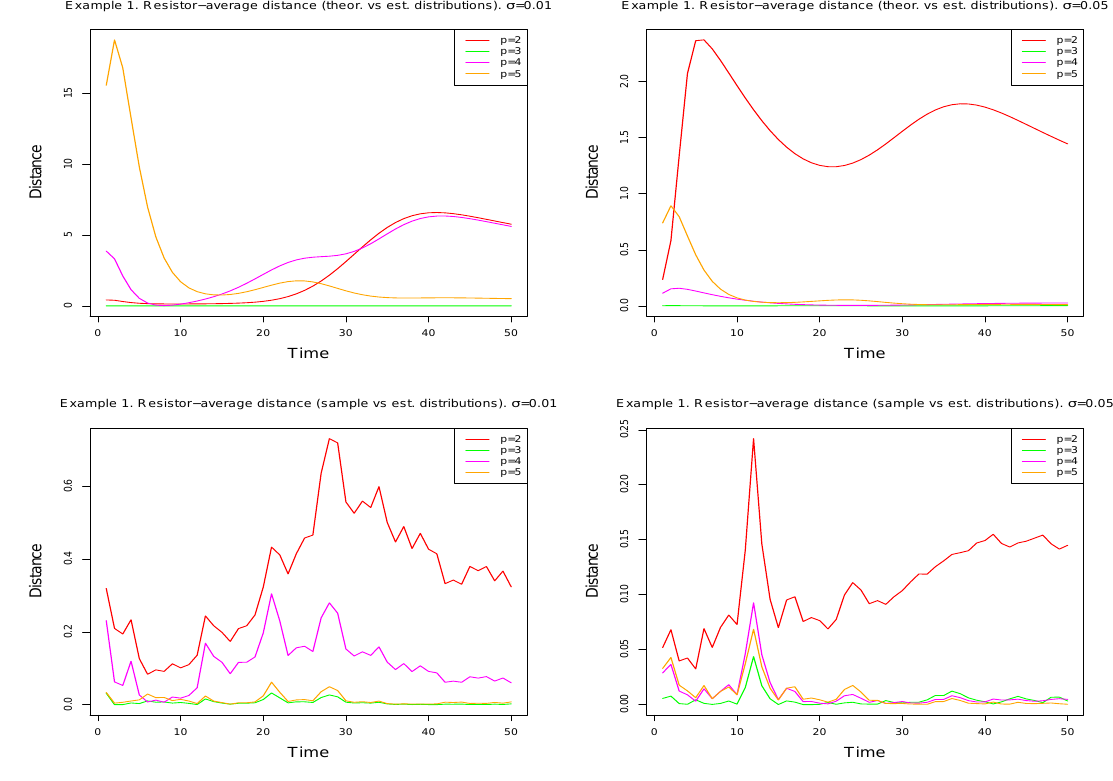
Figure 4. Example 1. Resistor-average distances between the theoretical and estimated models ( up ) and between the sample and estimated models ( down